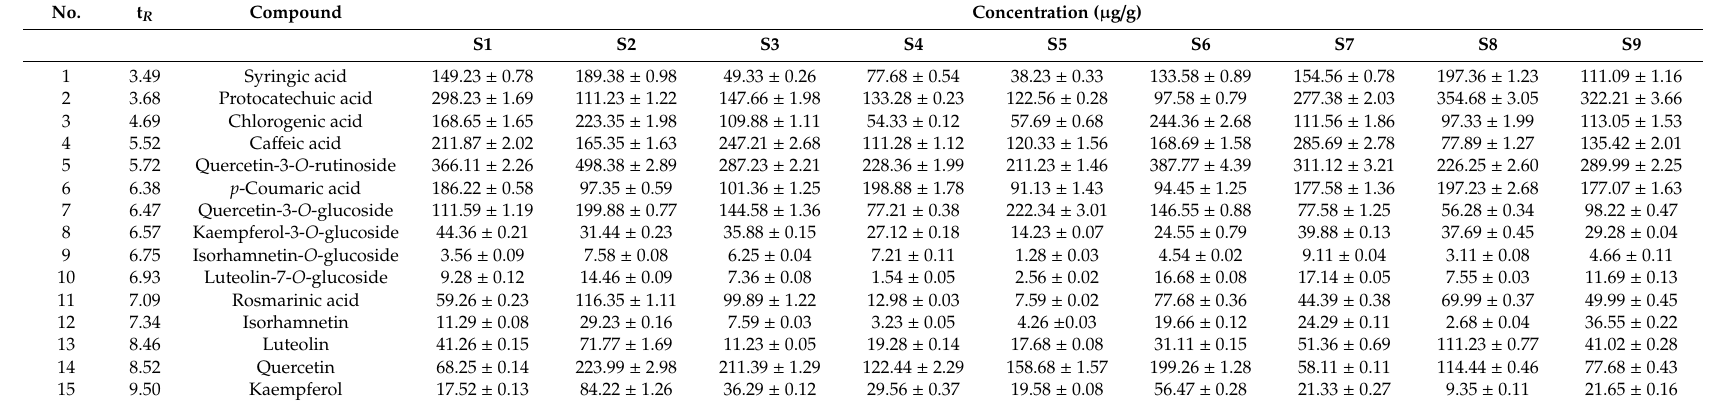
Table 1. The content ( µ g / g) of 15 phenolic compounds in the nine extract